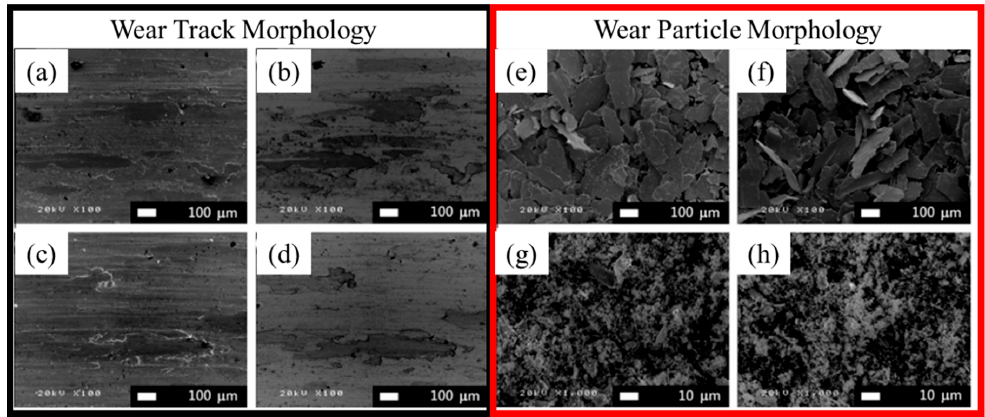
Figure 28. ( a – d ) Wear track morphology and wear particle morphology showing clear ( e , f ) delamination wear and ( g , h ) partial oxidation wear on the Al x Co 1.5 CrFeNi 1.5 Ti y alloys [91] (reprinted with permission from